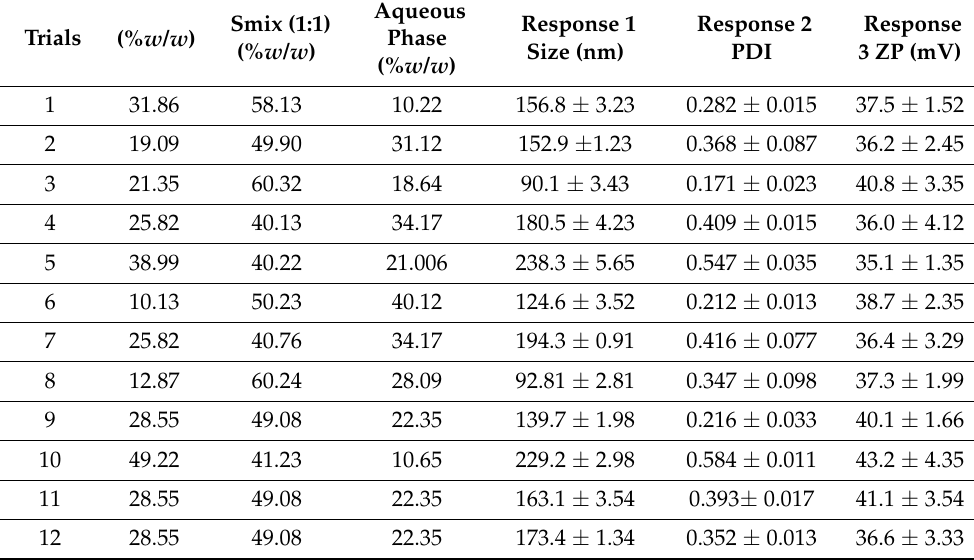
Table 1. Mean globule size, PDI, and zeta potential of ME formulations (mean ± SD, n = 3). Smix Trials (% w/w )